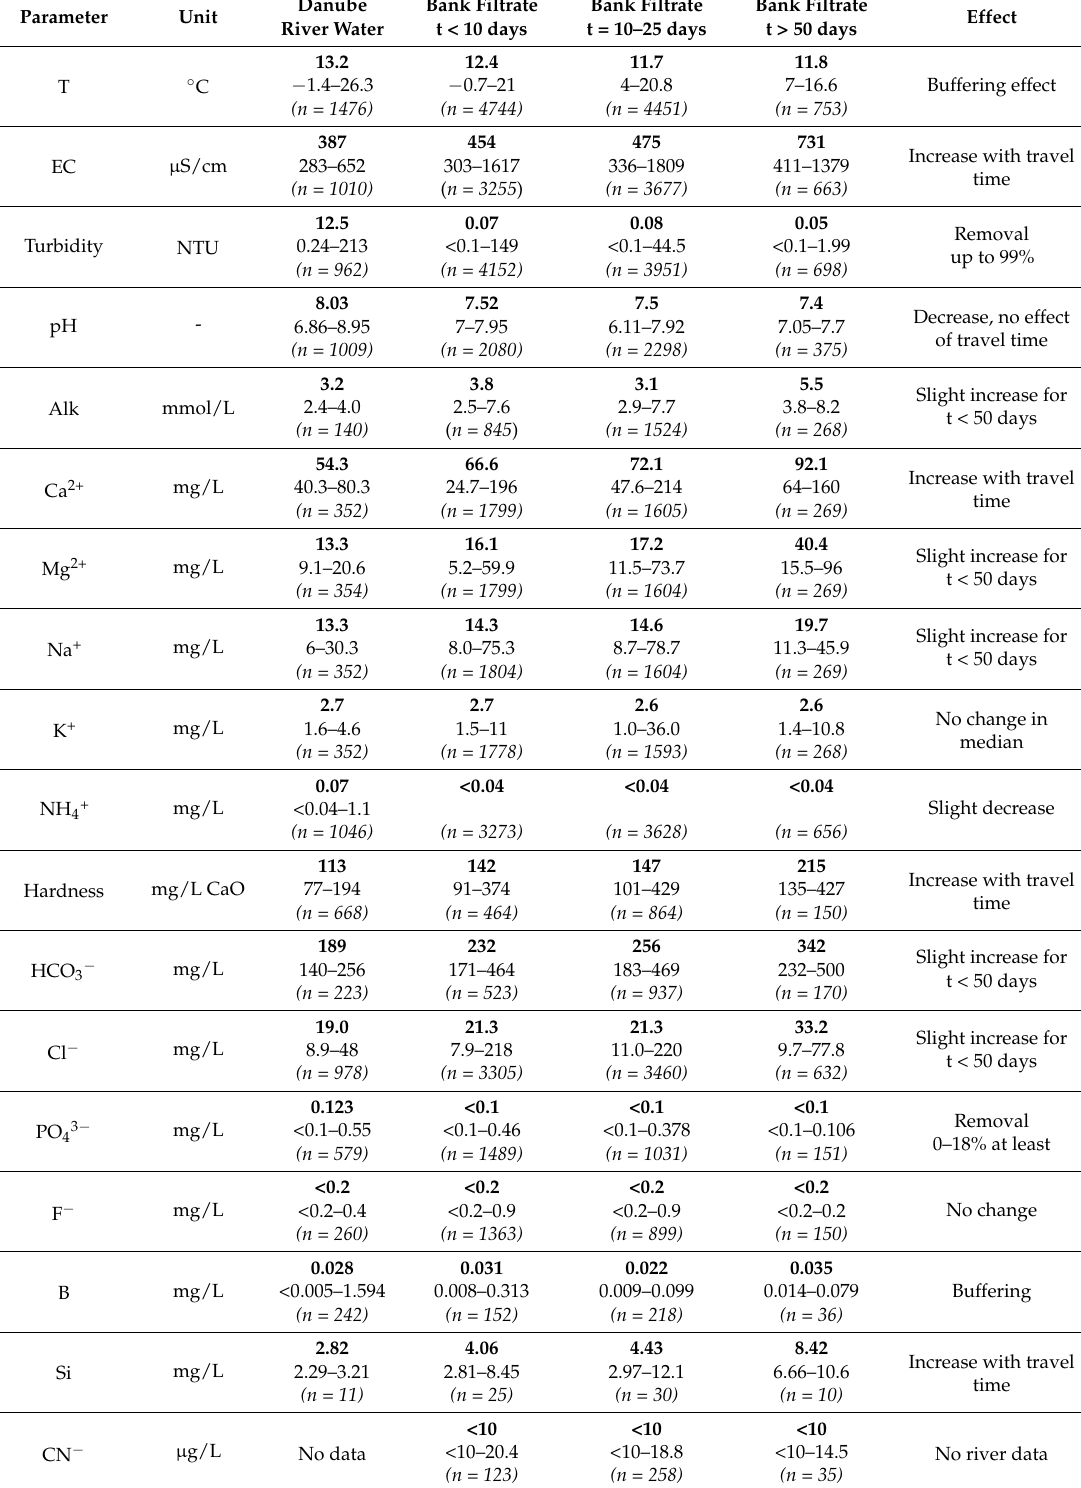
Table 2. Physical parameters and selected cations and anions, median (min–max) values of Danube River water and bank filtrate with different travel time (t), Budapest,